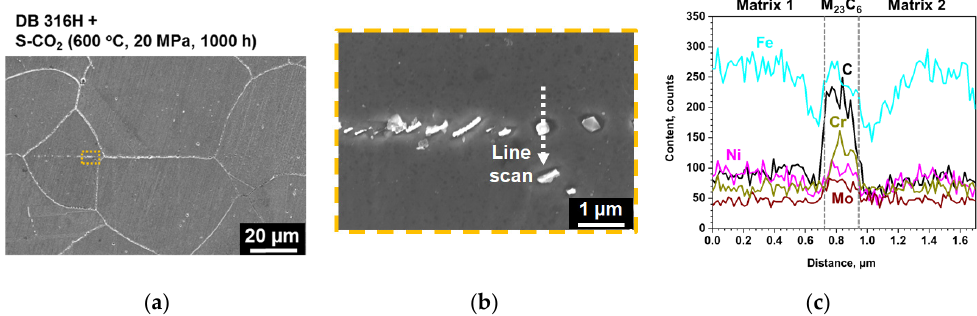
Figure 8. SEM analyses results of diffusion bonded SS 316H at the bond ‐ line after S ‐ CO 2 exposure at 600 °C (20 MPa) for 1000 h; ( a ) Low magnification, ( b ) high magnification of the box in ( a ), and ( c ) EDS line scanning.